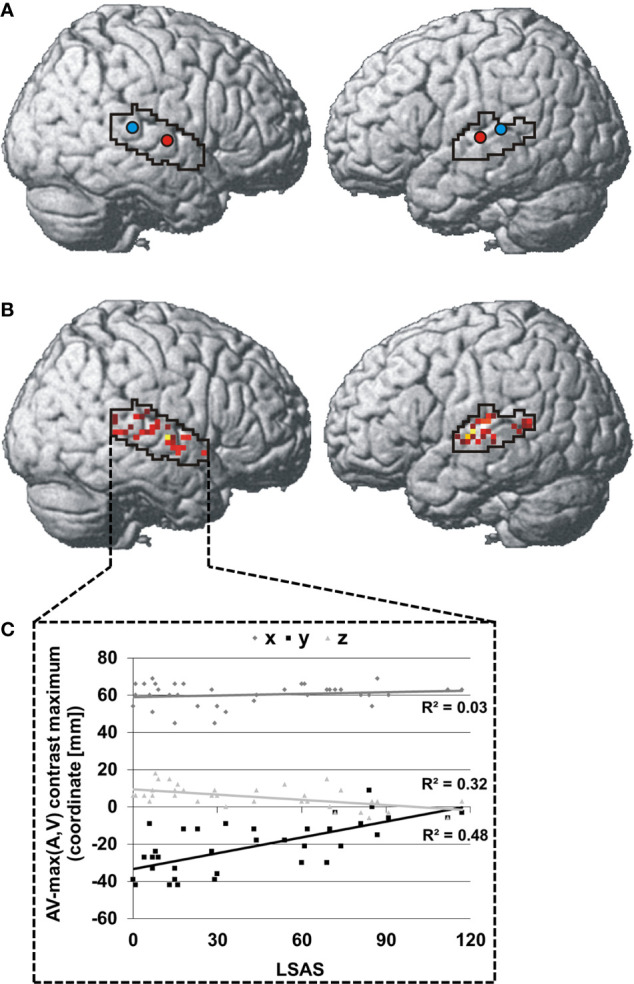
Spatial distribution of individual face-voice-integration maxima: Group centroids (SAD = red and HC = blue) (A) and individual face-voice-integration maxima (B) rendered onto the lateral aspects of a standard brain. Individual maxima are color-coded in a red-yellow-white spectrum with dark red indicating very low SA severity and white indicating very high SA severity. (C) Association between SA severity and the position of the individual face-voice-integration maximum within the right STS shown separately for the three spatial dimensions. Coordinates refer to the MNI system.